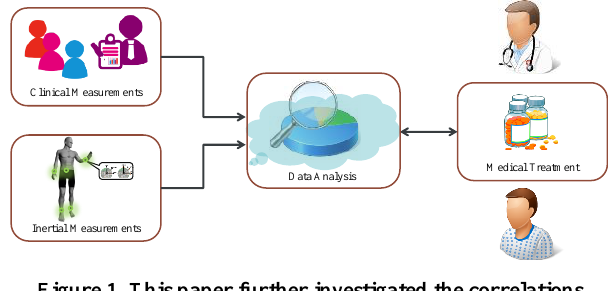
Figure 1. This paper further investigated the correlations between clinical measures including the 12-item Multiple Sclerosis Walking Scale (MSWS-12), Expanded Disability Status Scale (EDSS), and distance walked during 6MW, and two gait measures drawn from inertial body sensor data including the ratio between double stance time and single stance time (DST/SST) and the causality index, providing enhanced separability for tracking MS disease